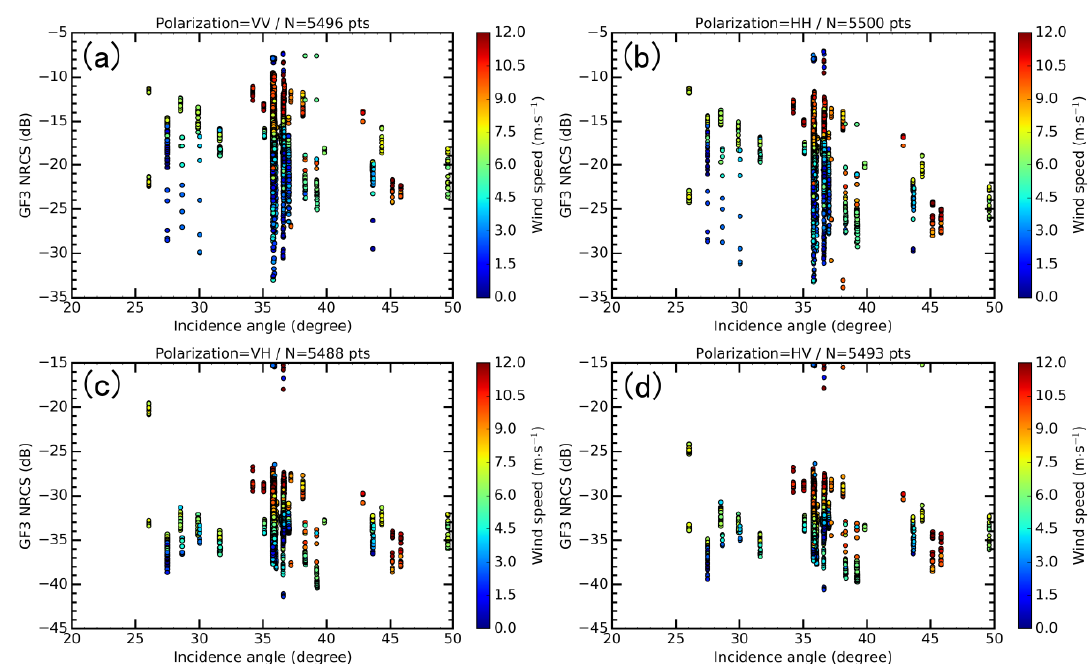
Figure 4. The GF-3 NRCS as a function of incidence angle for 4 different polarizations. The color bars represent the collocated wind speed from GFS. ( a ) For VV polarization; ( b ) for HH polarization; ( c ) for VH polarization; and ( d ) for HV polarization.